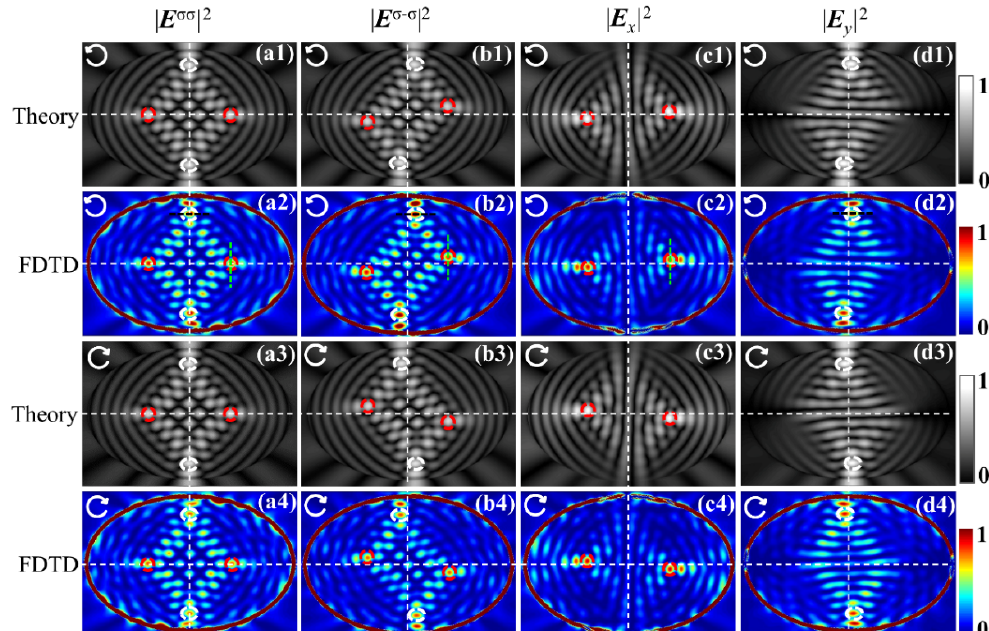
Figure 3. ( a1 – d4 ) Intensity maps of different components at the gold–air interface z = 0 obtained by finite-difference time domain (FDTD) simulation (rows 2 and 4) and numerical integral calculations based on Equations (6a)–(8b) (rows 1 and 3) for left-handed circular polarization (LCP) (rows 1 and 2) and right-handed circular polarization (RCP) (rows 3 and 4) illuminations. In the columns from left to right, the intensity maps are for the incident spin component, converted spin component (CSC), x -component, and y -component, respectively. The incidences are denoted by the white arrows.